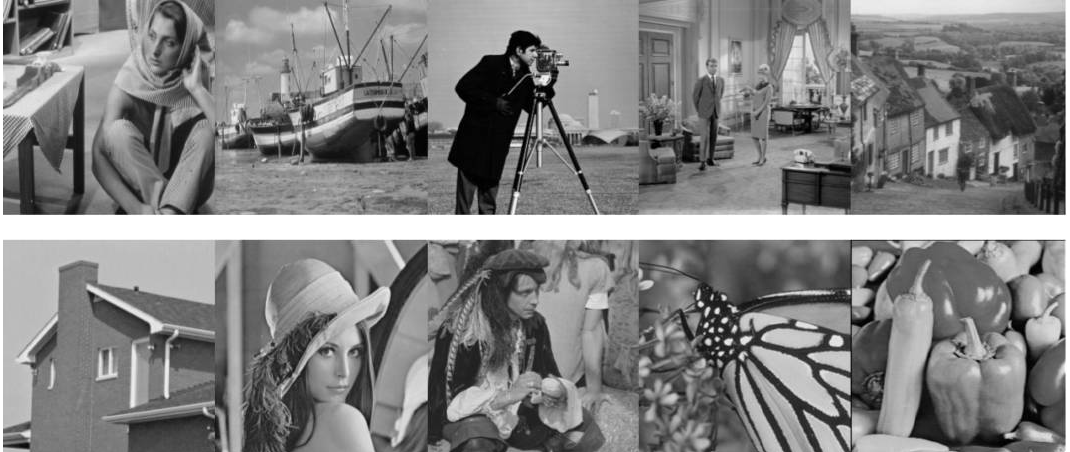
Figure 5. A range of 10 commonly used test images in the references.